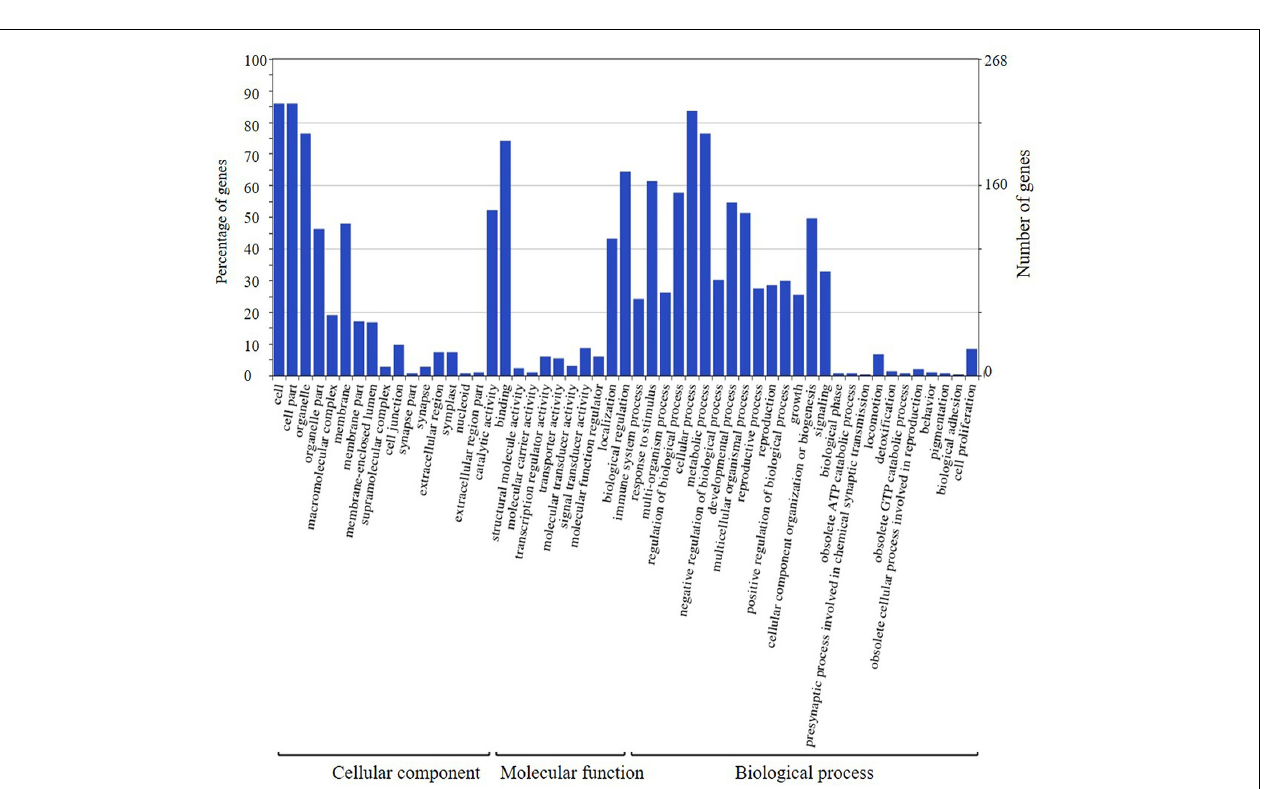
FIGURE 9 | Annotation information of genes in the high confidence interval of QTL detected on chromosome 6 through Gene ontology (GO) analysis.